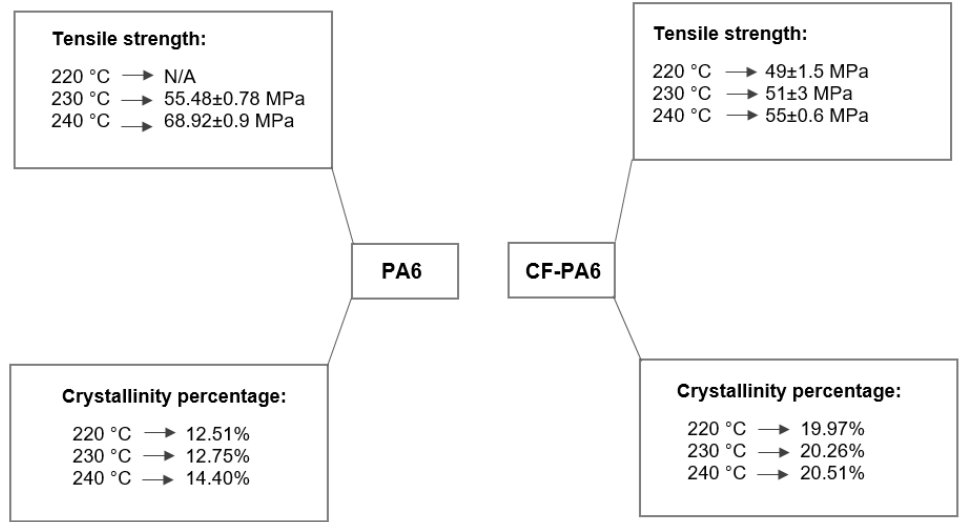
Figure 4. Obtained tensile strength and crystallinity percentage values concerning the liquefier temperature effect investigation.